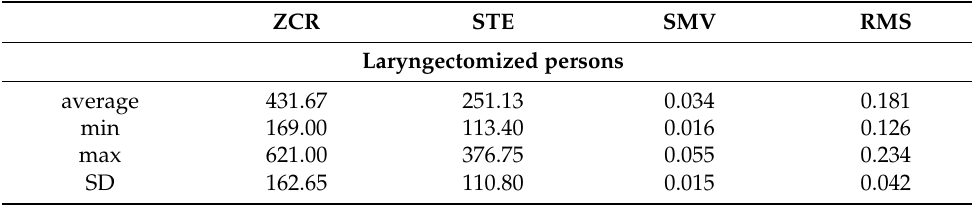
Table 2. The distribution of the values of the features: the first phonetic segments „be”—the word